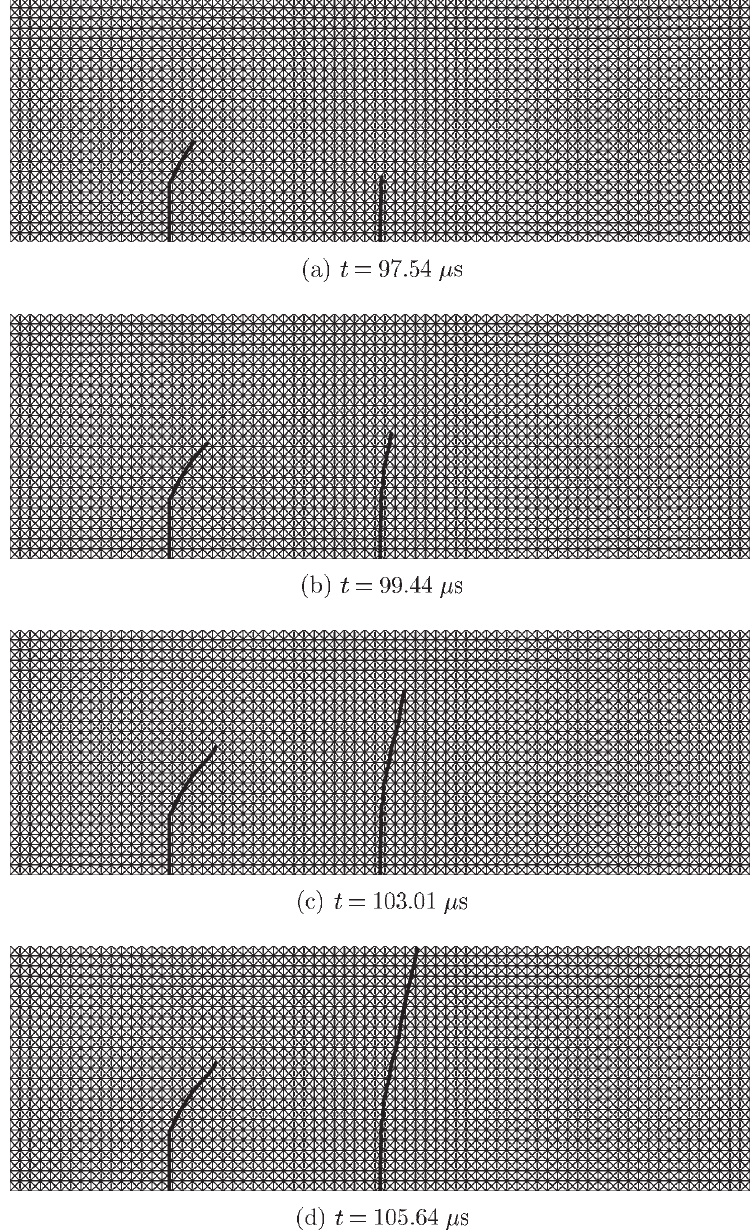
Fig. 9. Crack evolution for 73 × 24 cross-triangular mesh with γ =